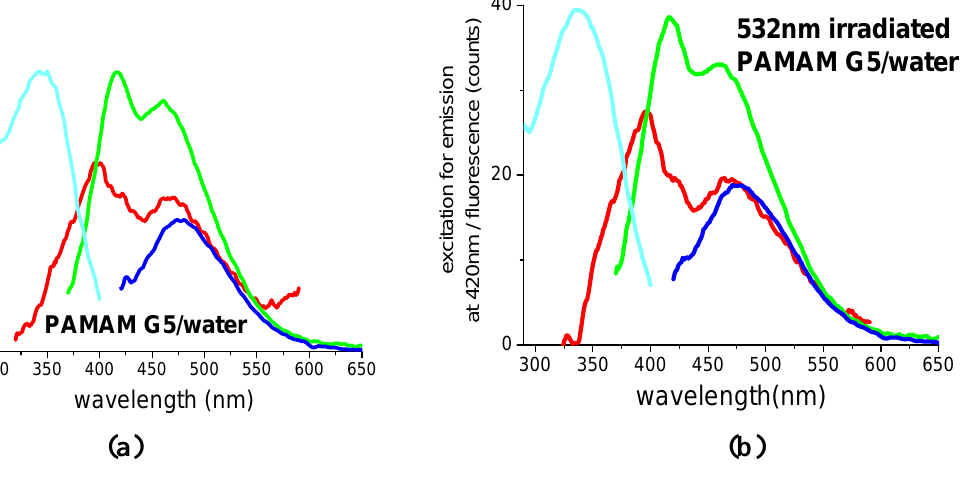
Figure 8. Excitation for emission at 420 nm (cyan curves) and fluorescence spectra of : PAMAM G5/water before (a) and after (b) irradiation with 532 nm, 8 mJ and 40,000 shots and (c) PAMAM G5-capped AuNPs after thorough bleaching with 532 nm, 8 mJ and 40,000 shots . Excitation wavelengths: 300 nm (red curves), 350 nm (green curves) and 400 nm (blue curves). Data corresponding to 300 nm excitation in (c) were multiplied by a factor of